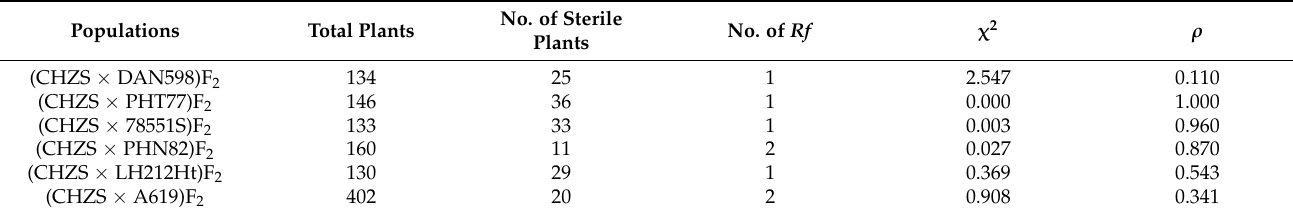
Table 4. Evaluation of the number of major restorer gene by the chi-squared